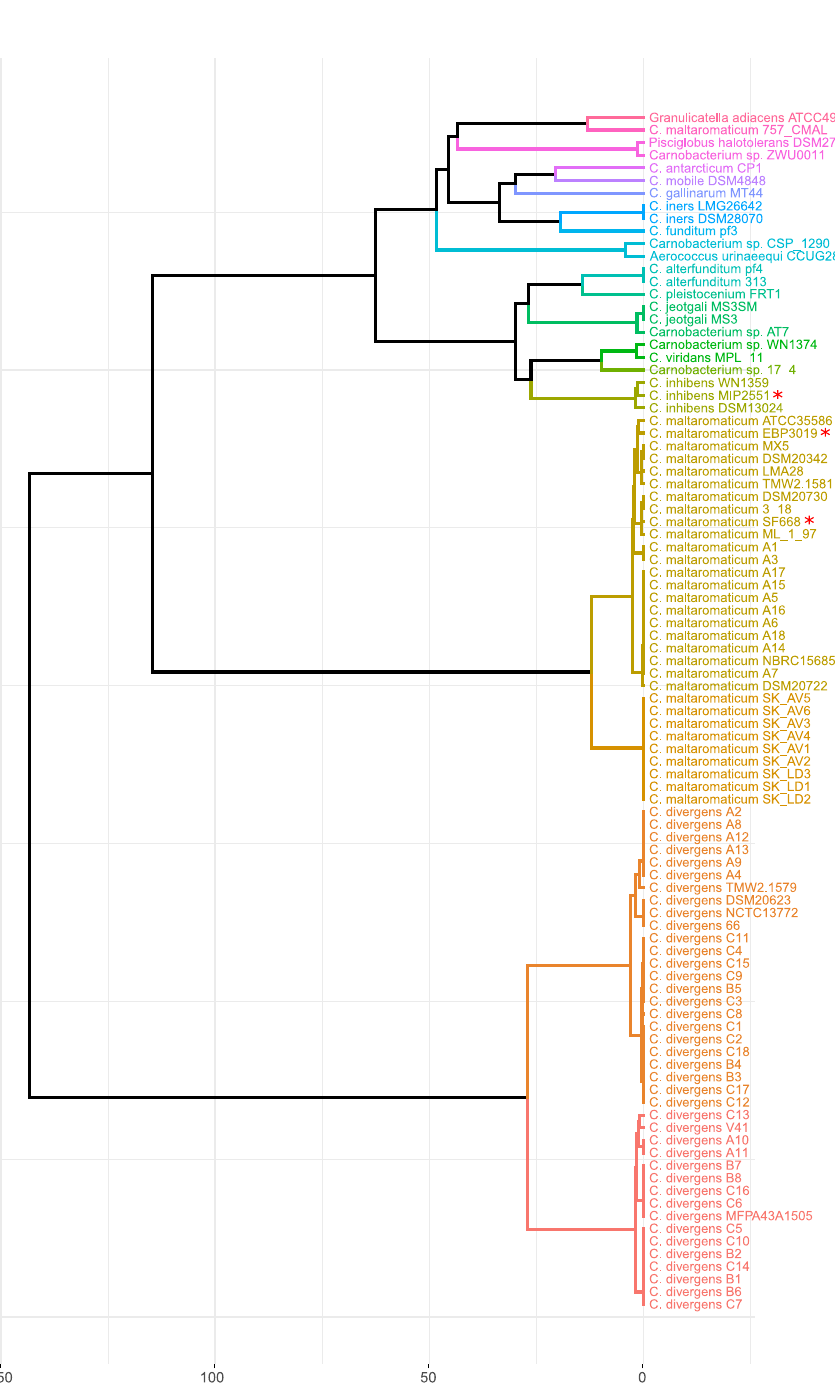
Figure 1. Average Nucleotide Identity (ANI) dendrogram of Carnobacterium spp. genomes and closed organisms — Pisciglobus halotolerans DSM27630T, Aerococcus urinaeequi CCUG28094T, and Granulicatella adiacens ATCC49175. The ANI similarity matrix was obtained with OrthoANIu (OrthoANI using USEARCH) provided by EzBioCloud. The dendrogram was constructed with RStudio using hclust {stats} and fviz_dend {factoextra}. The genomes sequenced in this study are highlighted with a red asterisk.